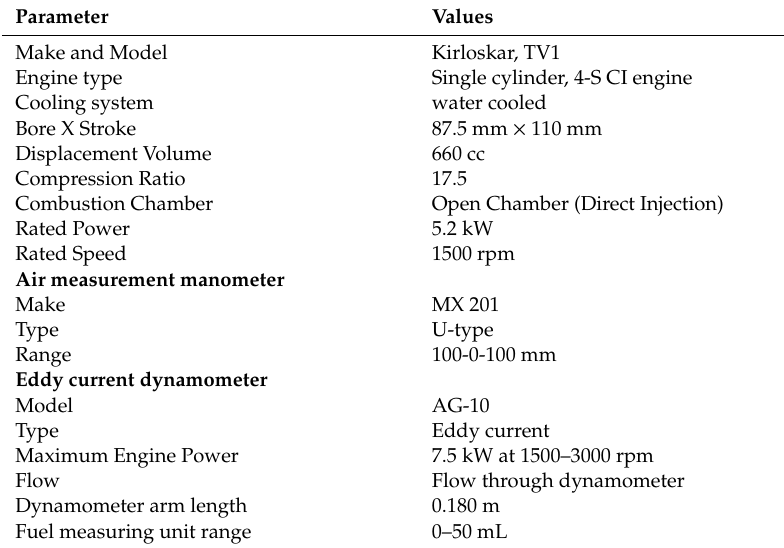
Table 3. Descriptions of the test rig.